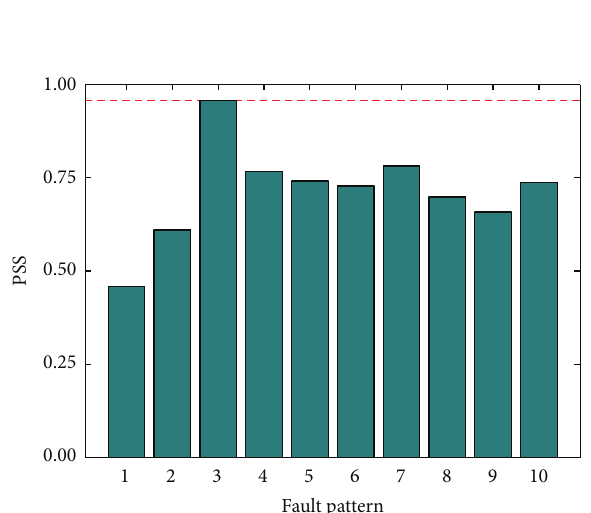
Figure 7: The PSS between the current data and every fault pattern.